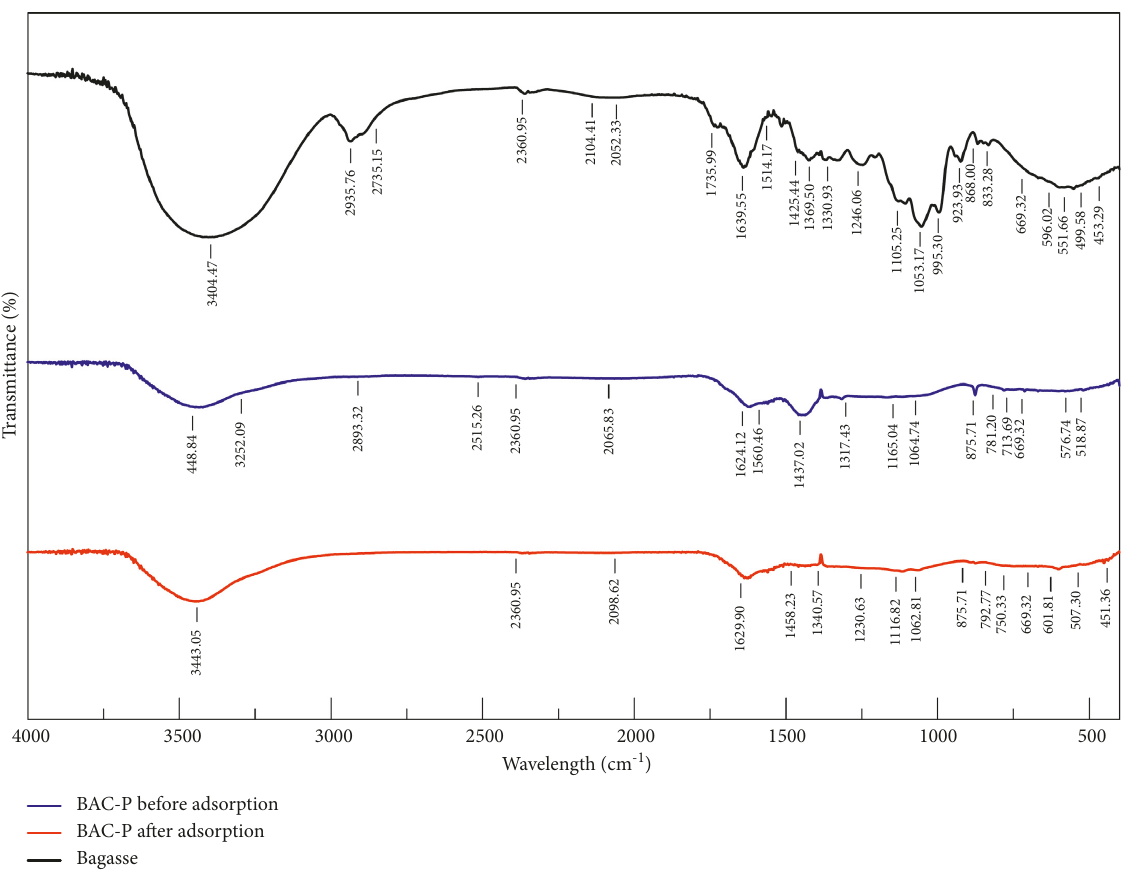
Figure 2: FTIR spectra of bagasse, BAC-P adsorbent before adsorption, and, BAC-P adsorbent after adsorption. Table 3: FTIR main transitions showing different bonds present in sugarcane